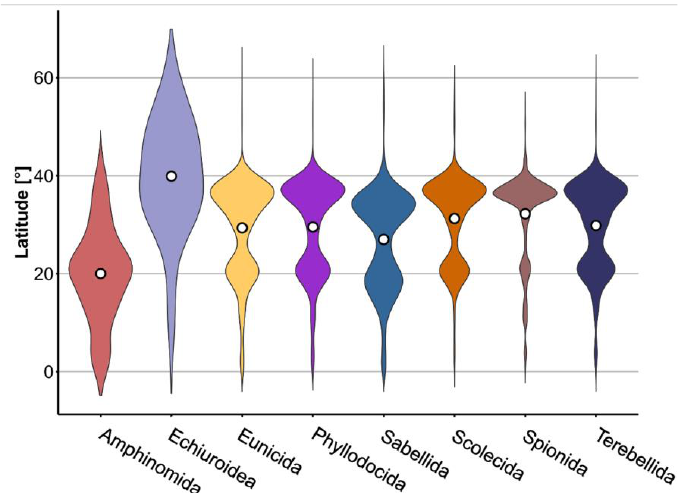
Figure 4. Violin plot representing the latitudinal distribution of polychaete records for each order across the Northwest Pacific. All plots have the same maximum width, making comparisons of density across the orders impossible. The white dots indicate the median. The sipunculan families Aspidosiphonidae and Siphonosomae occurred only within a limited latitudinal range, at latitudes 0–38° and around latitude 15°, respectively. The other sipunculan families, such as Golfingiidae, Phascolosomatidae and Sipunculidae, were found along the whole latitudinal gradients from the equator to latitude 65°. The family Golfingiidae had a peak of occurrence records at around 45° and Sipunculidae had a peak around 30°, while Phascolosomatidae was more evenly distributed (Figures 5 and S9). Figure 5. Violin plot representing the latitudinal distribution of Sipuncula records for five families across the Northwest Pacific. All plots have the same maximum width making comparisons of density across the families impossible. The white dots indicate the median. Comparing the latitudinal distribution between shallow-water and deep-sea records (Figure S4C,D), the maximum of records was reported at 45° latitudes for